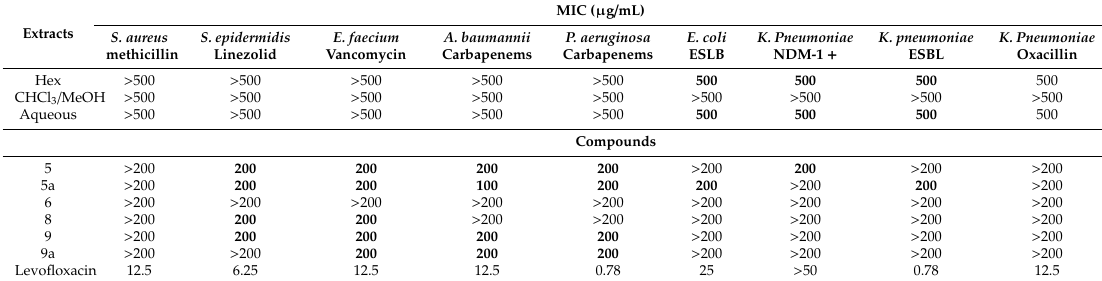
Table 3. Activity of H. glomerata leaves extracts, major isolated compounds, and their semisynthetic derivatives against resistant